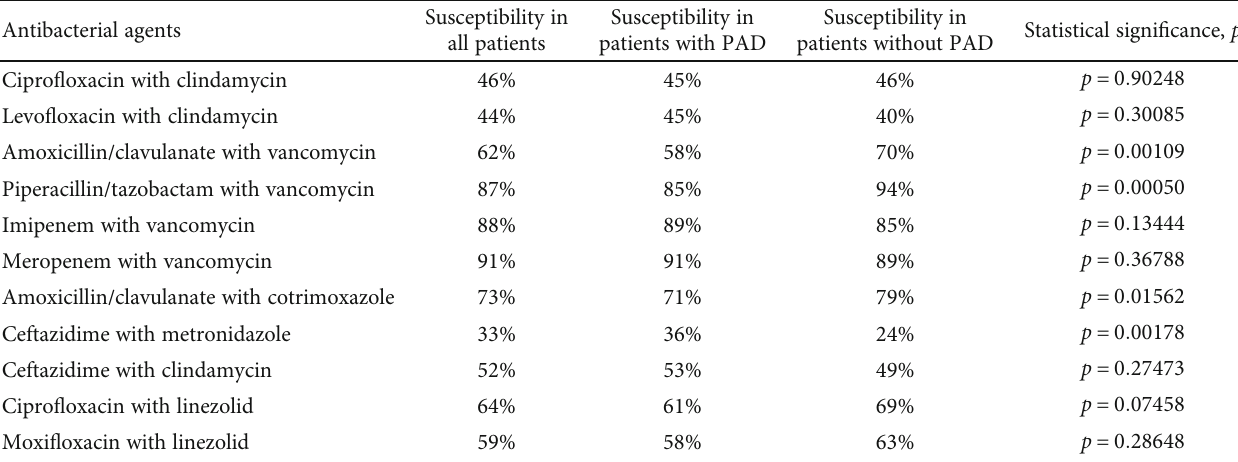
Table 6: Susceptibility of isolates to the most commonly recommended combinations of antibacterial agents in the literature in patients with and without peripheral arterial disease